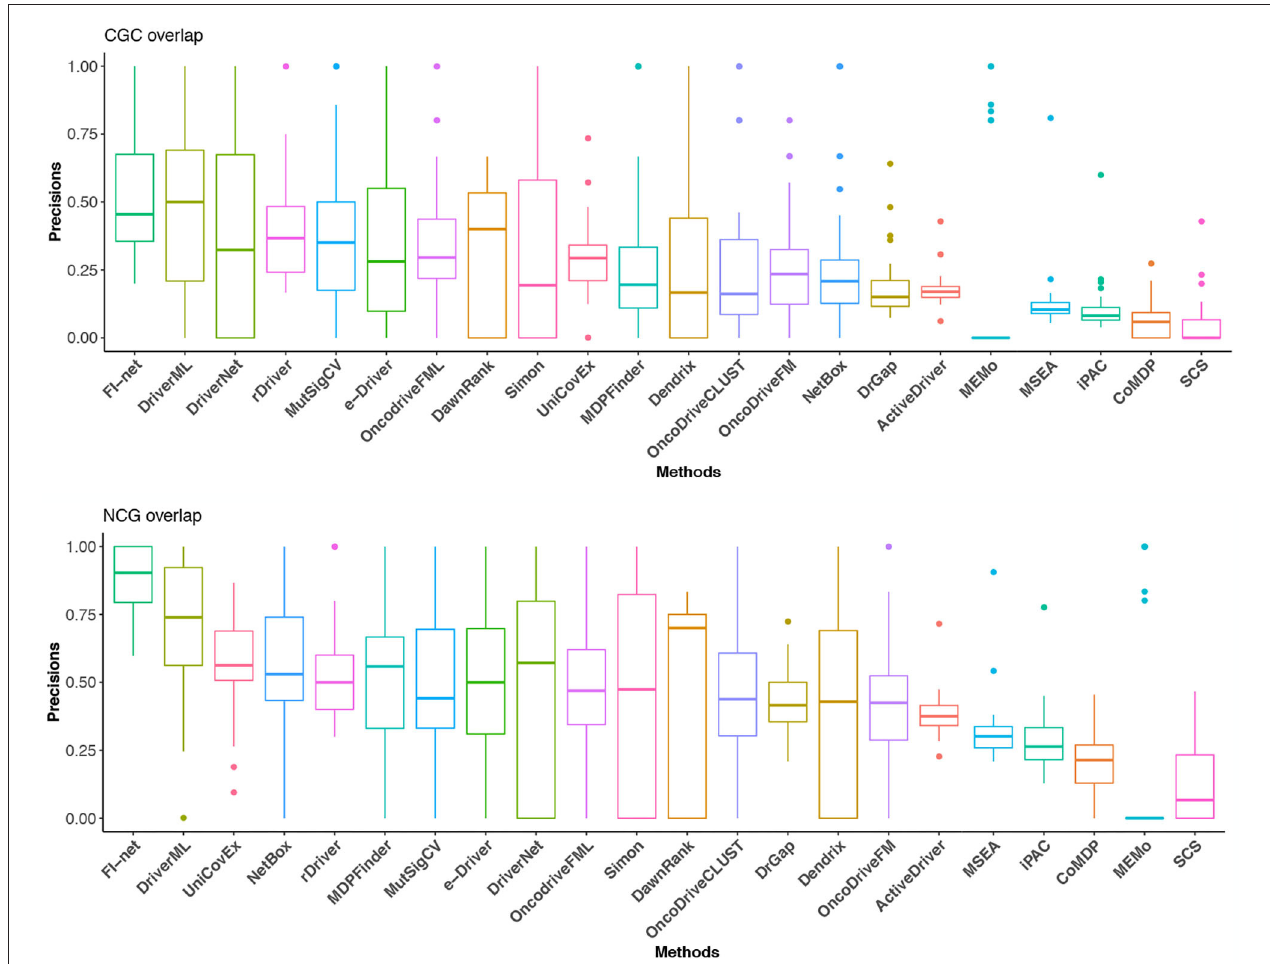
FIGURE 5 | The precisions in CGC and NCG of the 22 methods in the 31 TCGA datasets. Methods are sorted with respect to the mean of